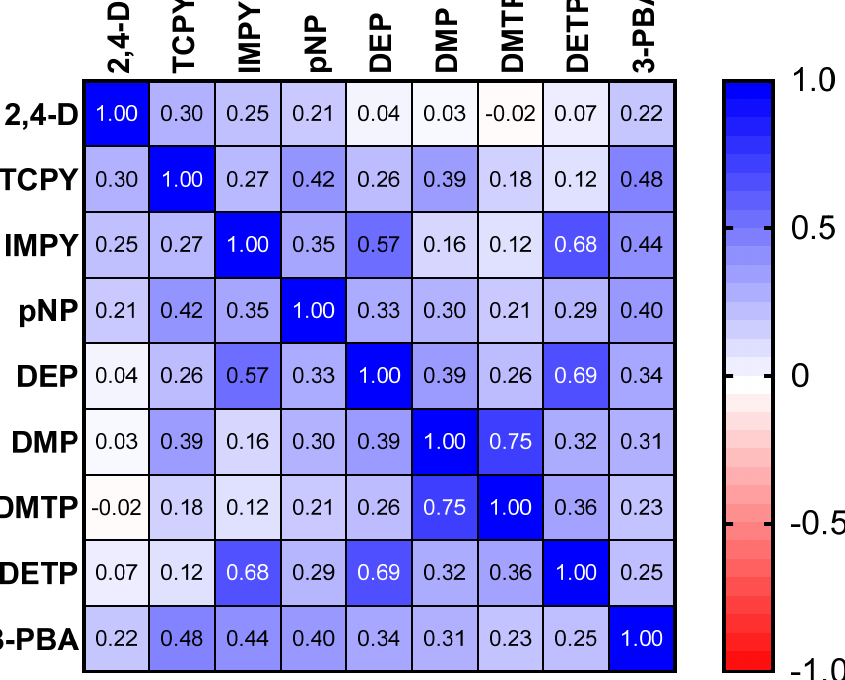
Figure 1. Spearman correlation matrix of specific gravity adjusted urinary pesticide metabolite concentrations.